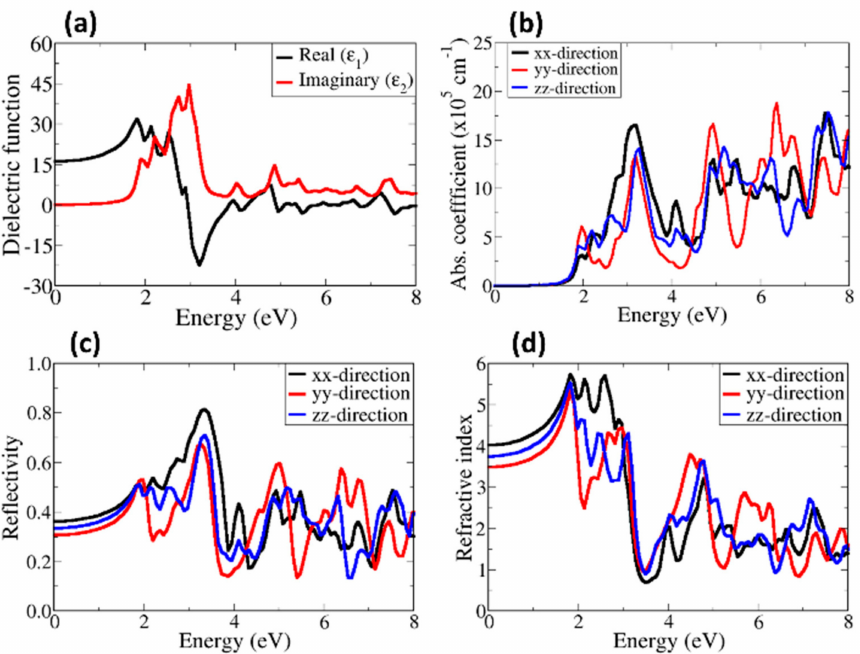
Figure 7. Calculated ( a ) dielectric function, ( b ) absorbance, ( c ) reflectivity and ( d ) refractive index of β –SrZrS 3